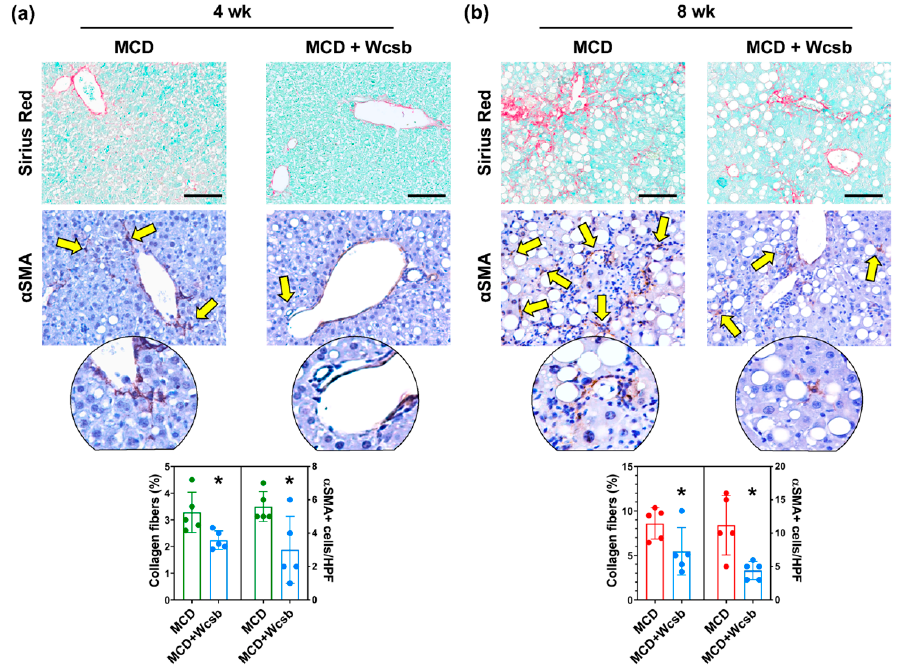
Figure 3. Effects of calcium-sulphate-bicarbonate water (W csb ) on fibrosis and hepatic stellate cell (HSC) activation in mice subjected to a methionine-choline-deficient (MCD) diet. ( a , b ) Sirius red/fast green (SR/FG) stain (upper panels) and immunohistochemistry for α -smooth muscle actin ( α SMA) on mouse livers after four weeks (4wk) or eight weeks (8wk) of MCD diet administration, with or without W csb . Mineral water administration was associated with lower collagen fiber deposition and with a lower number of activated α SMA+ HSCs (arrows) in MCD mice. Scale bars: 100 μ m ( upper panels ) and original magnification: 20× ( lower panel ). Areas in the circles are 40× magnifications. Histograms show means and standard deviations for the area percentage of the liver occupied by collagen fibers and for the number of α SMA+ HSCs per high-powered field (HPF). Data from each animal are plotted as solid circles in the graph. * p < 0.05 vs. MCD. 2.4. Hepatocyte LPS Localization and TLR4+ Macrophages in the Liver of MCD Mice LPS localization in hepatocytes was studied using immunohistochemistry stains of liver sections (Figure 4). Hepatocyte LPS localization was higher in MCD-4wk mice (28.4 ± 5.2%) and in MCD-8wk mice (31.0 ± 10.4%) compared to controls (6.0 ± 2.6%; p < 0.001); no differences were present among MCD-4wk and MCD8-wk mice. When mice sacrificed after four weeks of treatment were analysed, MCD/W csb mice showed a lower LPS hepatocyte content (13.6 ± 3.9%) compared to MCD-4wk mice ( p < 0.001). Similarly, at eight weeks, MCD/W csb mice showed a significantly lower number of LPS+ hepatocytes (10.4 ± 2.0%) compared to MCD-8wk mice ( p = 0.002).